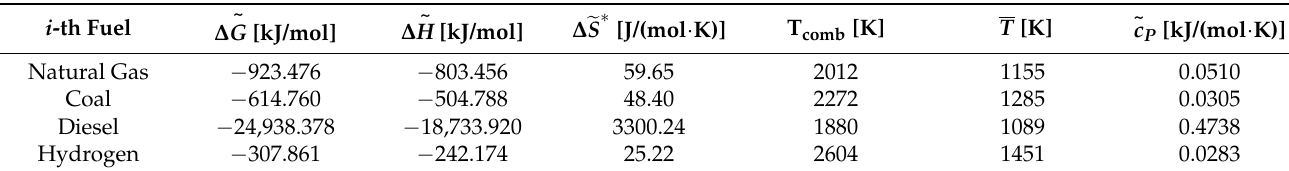
Table 1. Main thermodynamic properties for the calculation of the EGN concerning the combustion quality. i -th Fuel